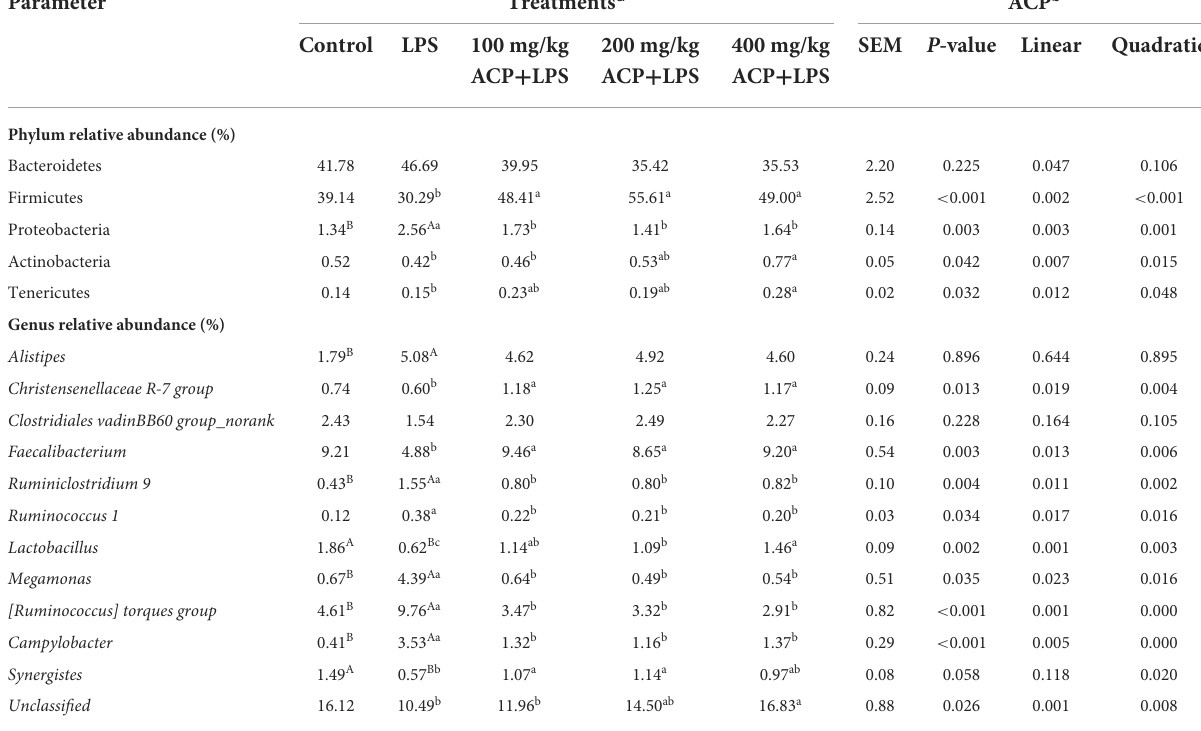
TABLE 7 Effects of Antrodia cinnamomea polysaccharide on microbiome composition in the cecum of slow-growing broiler breeds challenged with